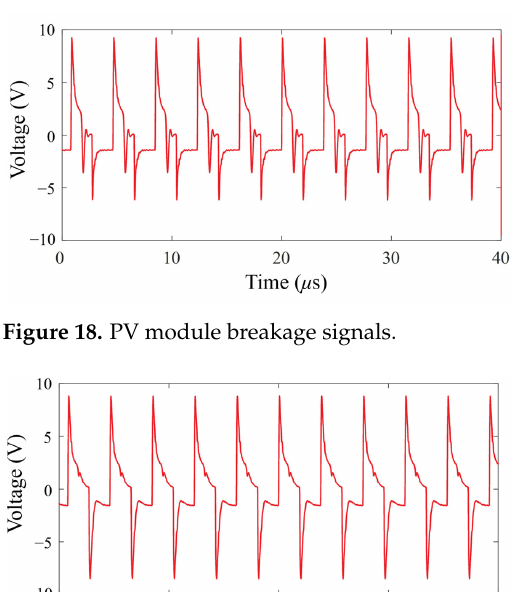
Figure 17. Poor connection signals of a PV module.